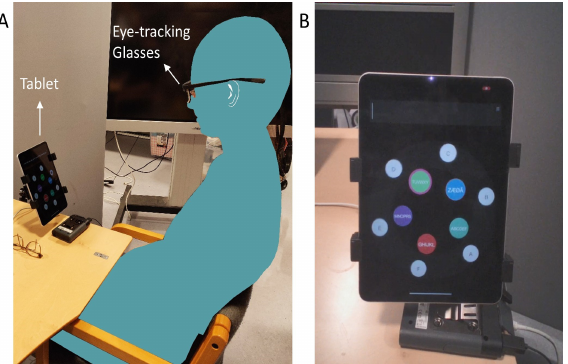
Figure 3. (A) The experimental setup with the eye-tracking glasses and the tablet and (B) a representative snapshot of the camera view from the eye-tracking